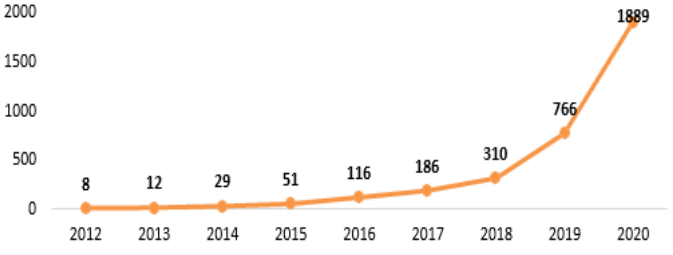
Figure 3. Evolution of the Number of Citations per Year.